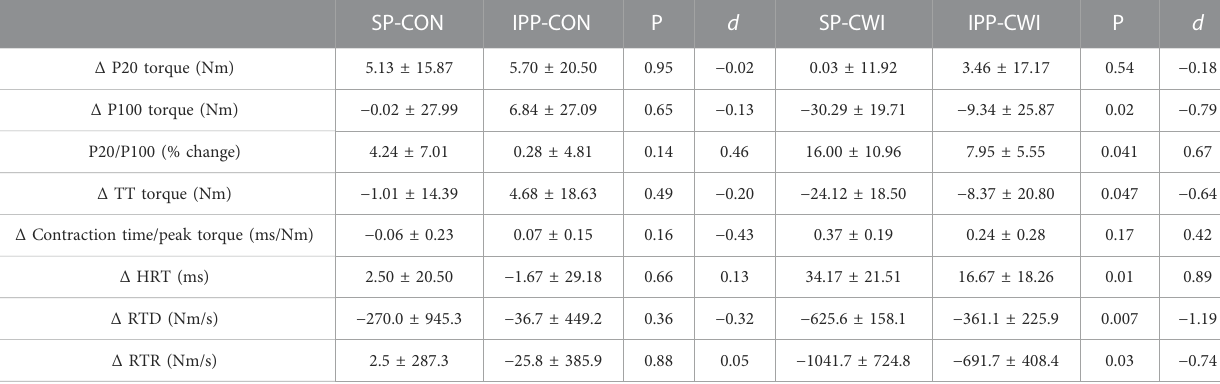
TABLE 3 Changes in torques and contractile properties in the unfatigued state.